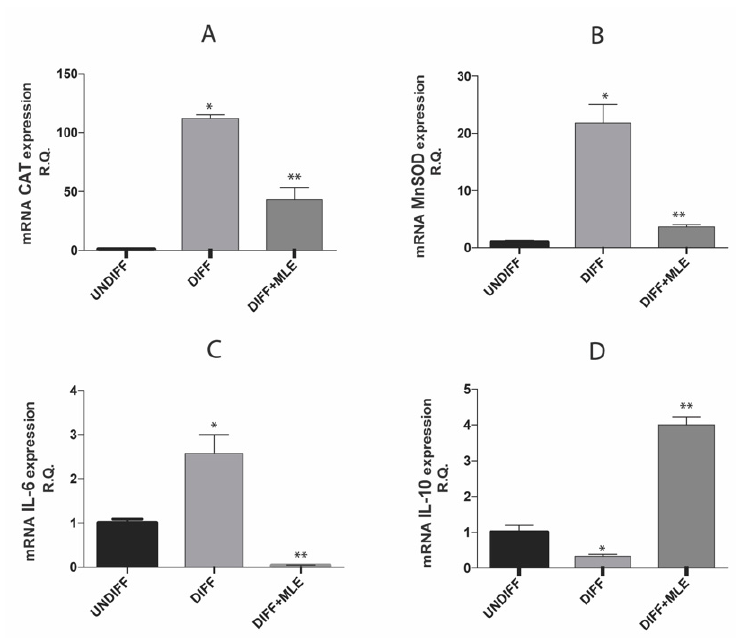
Figure 6. Gene expression CAT ( A ), MnSOD ( B ), IL-6 ( C ) and IL-10 ( D ) evaluated by RT-PCR. Bars represent the mean ± SEM of six independent experiments. * p < 0.05 versus undifferentiated cells; ** p < 0.05 versus differentiated cells.